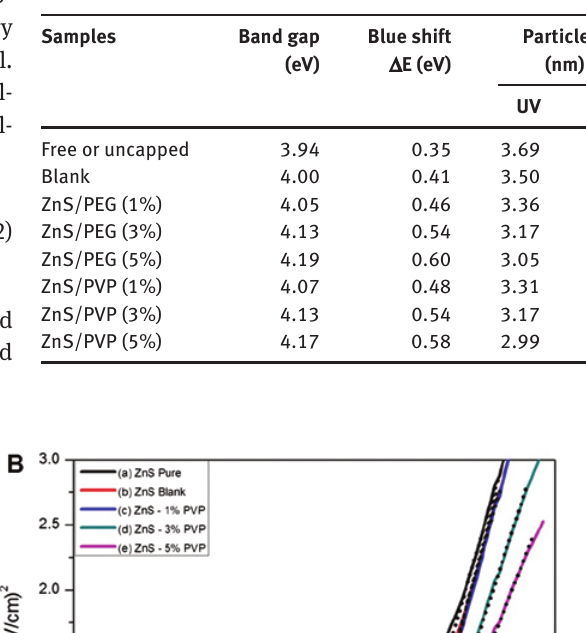
Table 1: Optical band gap, blue shift, and particle size of the ZnS